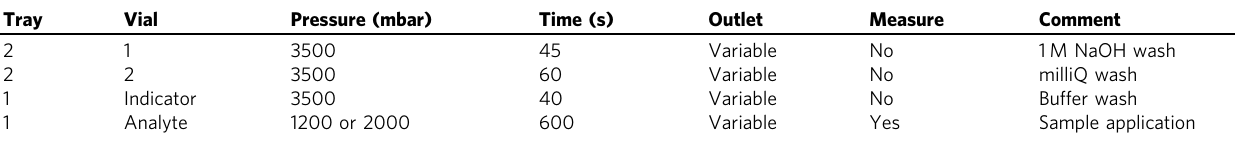
Table 3 Experimental parameters for Cap fl ex analysis of α -Syn on the FIDA 1 instrument.